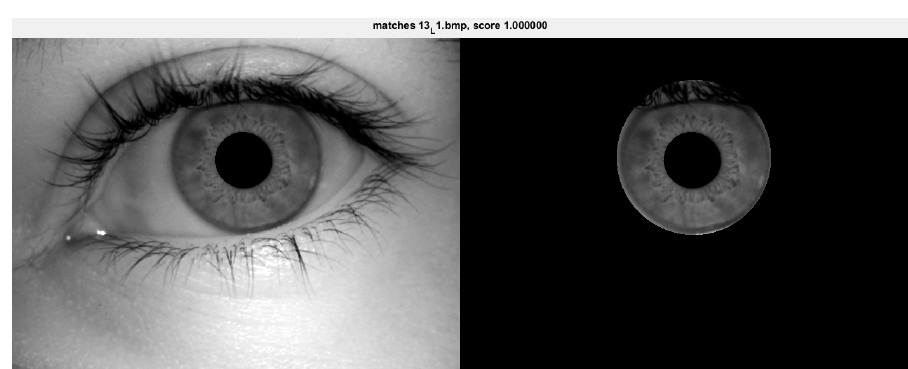
Figure 9. Results of applying principal component analysis. Algorithm 4: Principal Component Analysis